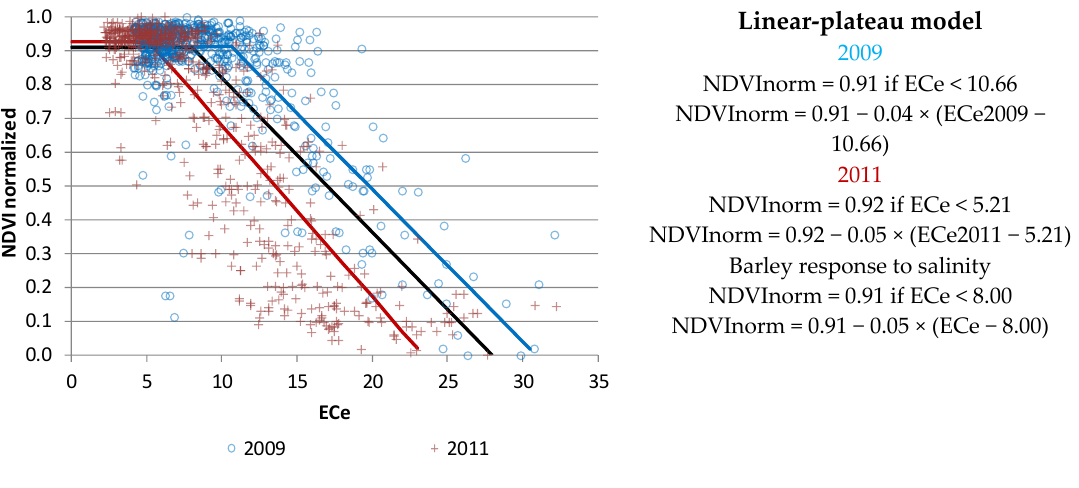
Figure 8. Salinity–NDVI linear response plateau model for barley in 2009 (blue line), 2011 (red line), and function of barley production response to salinity adapted from Ayers and Westcot [48] (black line).